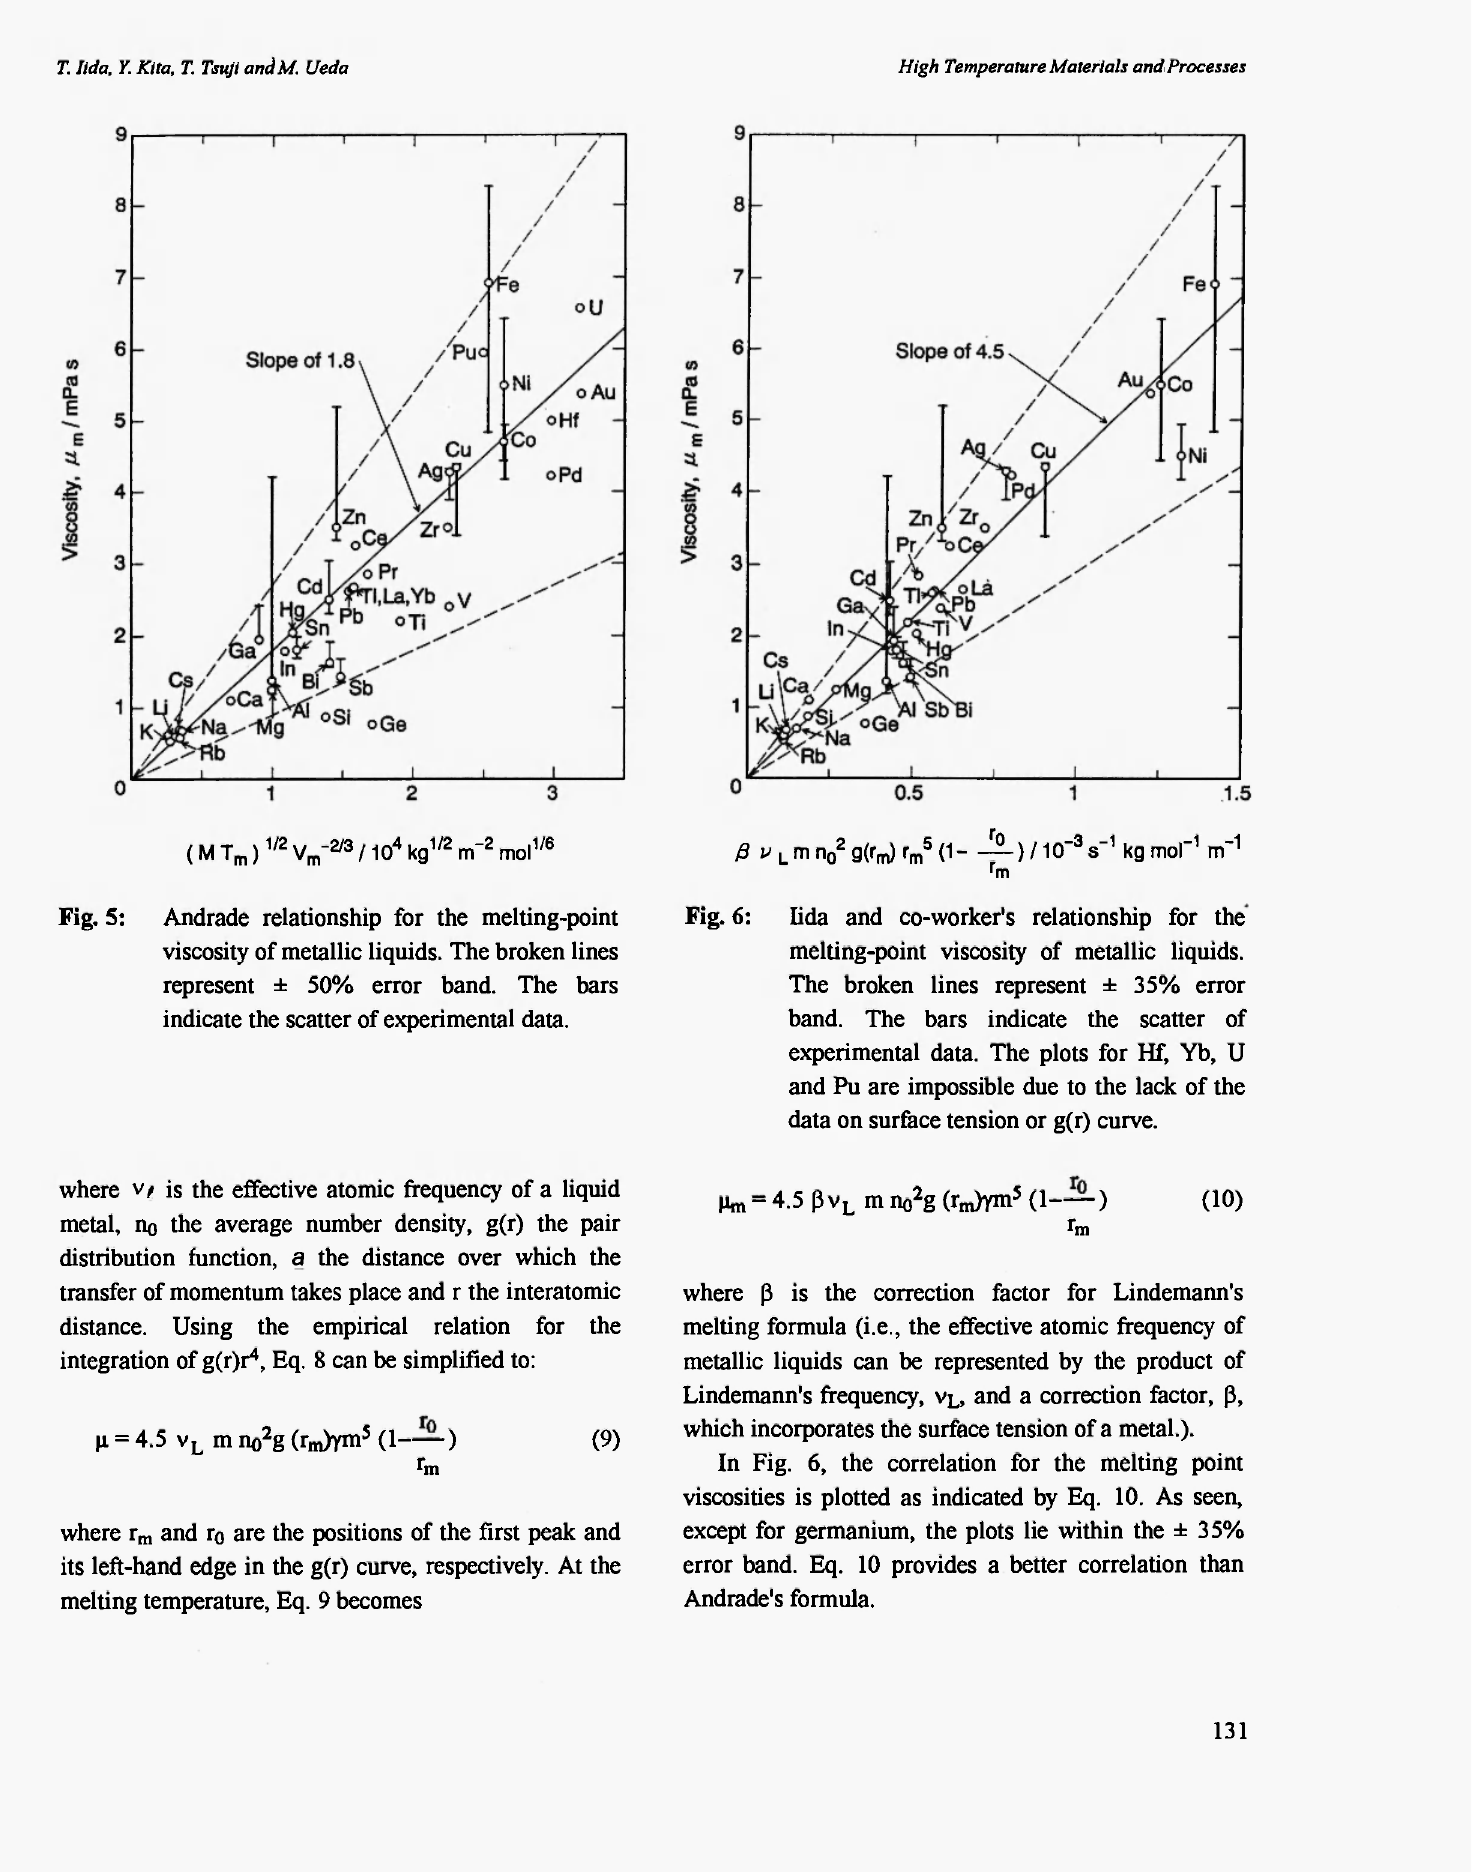
Fig. 6: Iida and co-worker's relationship for the melting-point viscosity of metallic liquids. The broken lines represent ± 35% error band. The bars indicate the scatter of experimental data. The plots for Hf, Yb, U and Pu are impossible due to the lack of the data on surface tension or g(r)